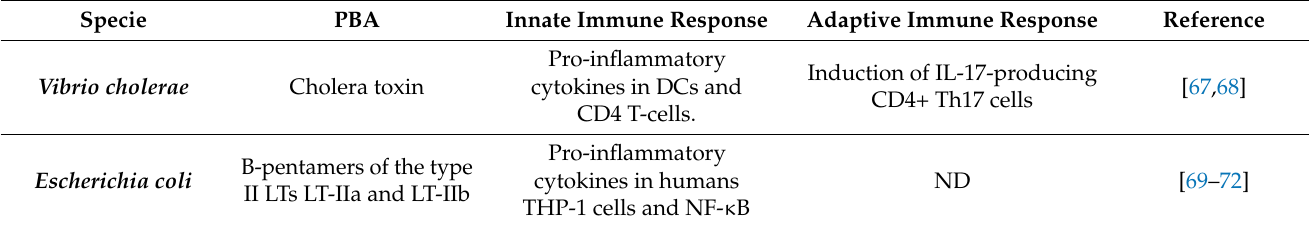
Table 2. Bacterial PBAs with TLR2 and GM1 Ganglioside adjuvant